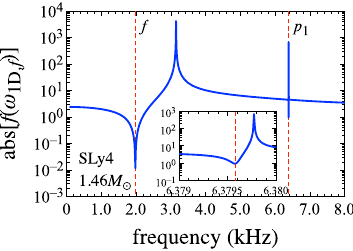
Fig. 5 For the neutron star model with 1 . 46 M (cid:2) constructed with SLy4 EOS,weshowtheabsolutevalueof f (ω 1D , f ) asafunctionoffrequency. The verticaldashed linesdenote the Re (ω)/ 2 π forthe f -and p 1 -modes determined through the proper eigenvalue problem without the approx- imation. The panel inserted in the figure is an enlarged drawing in the vicinity of the p 1 -mode frequency